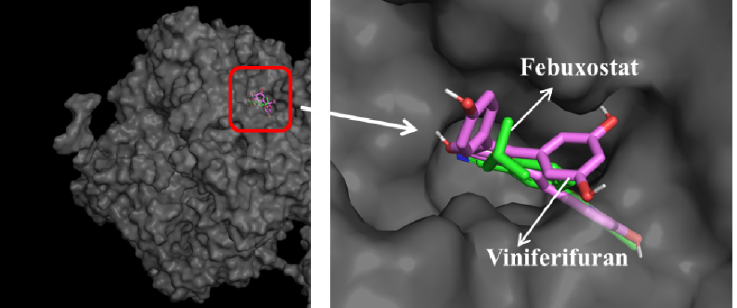
Figure 10. Docking results of viniferifuran (pink-purple)–XO and febuxostat (green)–XO and superimposed docking conformations of viniferifuran and febuxostat in the active pocket of XO.